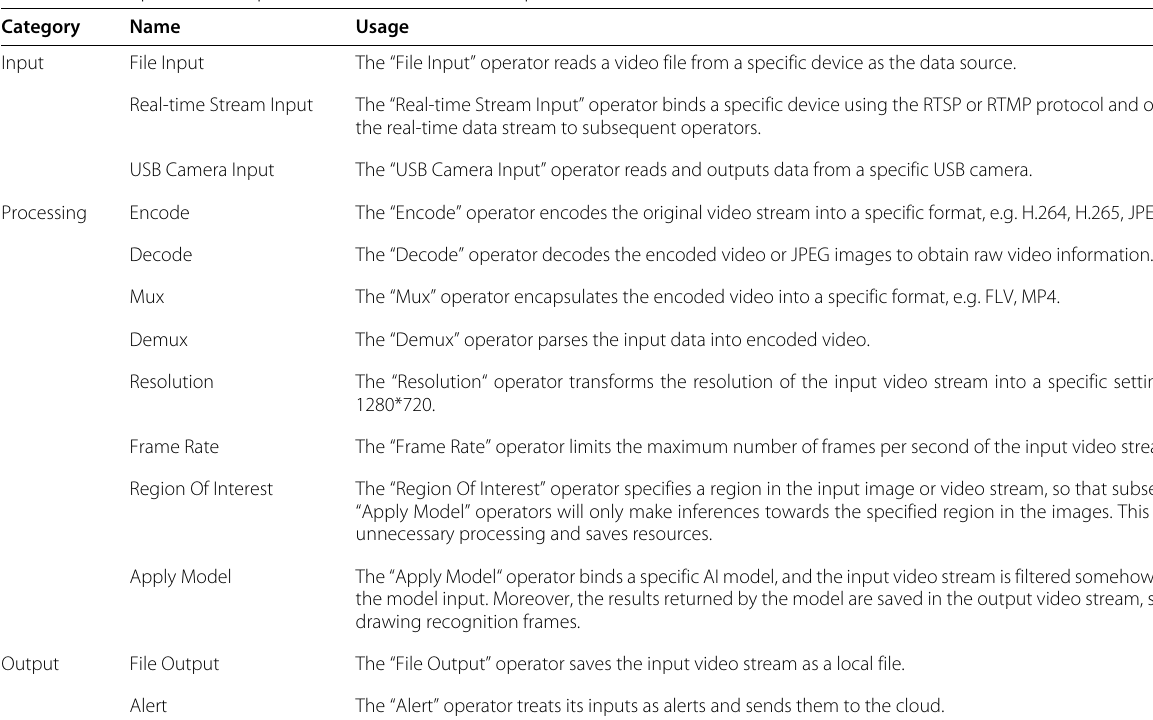
Table 2 Pre-implemented operators for multimedia data (partial.)